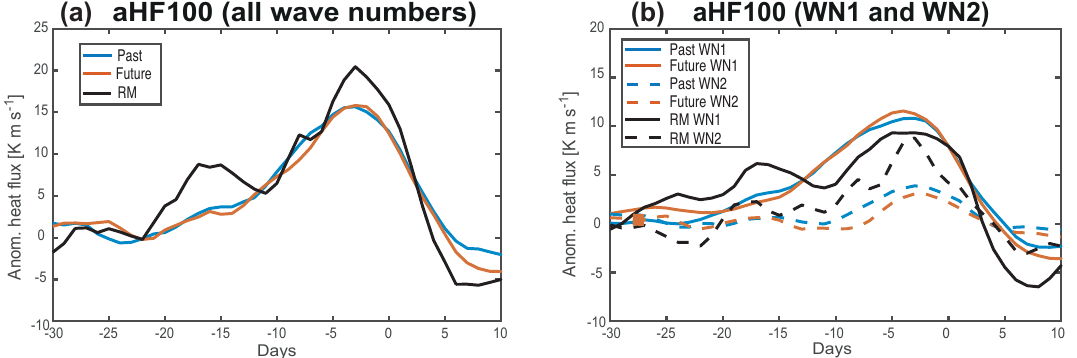
Figure 3. (a) Multi-model mean of anomalous heat flux (Kms − 1 ) at 100hPa averaged over 45–75 ◦ N from 30 days before until 10 days after the occurrence of SSWs. (b) Same as (a) but for WN1 (solid lines) and WN2 (dashed lines) wave components. Thick lines denote statistically significant future values different from the past ones at the 95% confidence level. RM stands for reanalysis mean (JRA-55 and